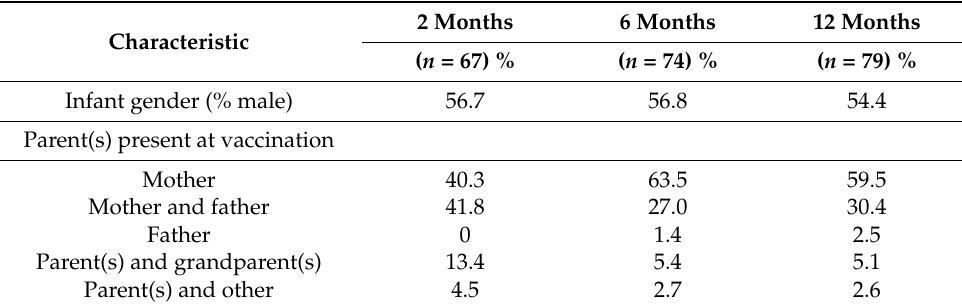
Table 1. Demographic